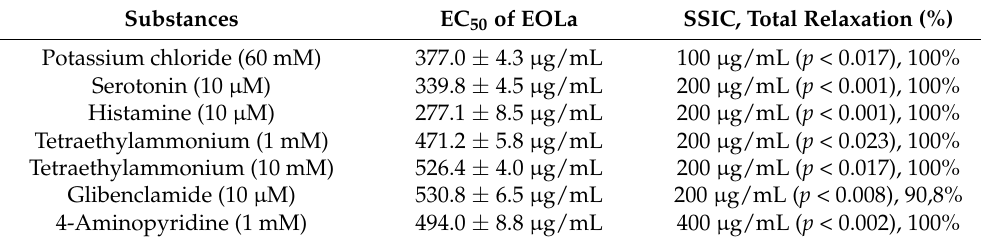
Table 1. Contraction agonists and blocking agents (substances); concentration values capable of triggering 50% of relaxing response (EC 50 ); values of statistically significant initial concentrations (SSIC) and total relaxation (%) promoted by the Lippia alba essential oil in the presence of differing contractile agents and channel